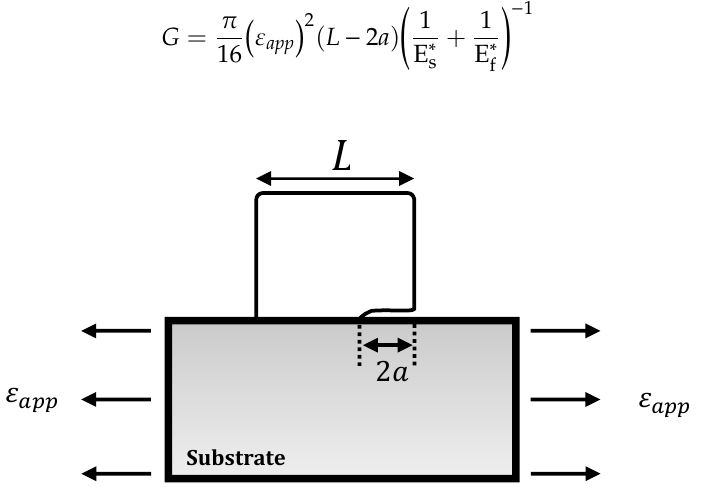
Figure 9. Schematic of asymmetric debonding of a cube “island” on a compliant or soft substrate under the assumptions of plain strain conditions adapted from [41].